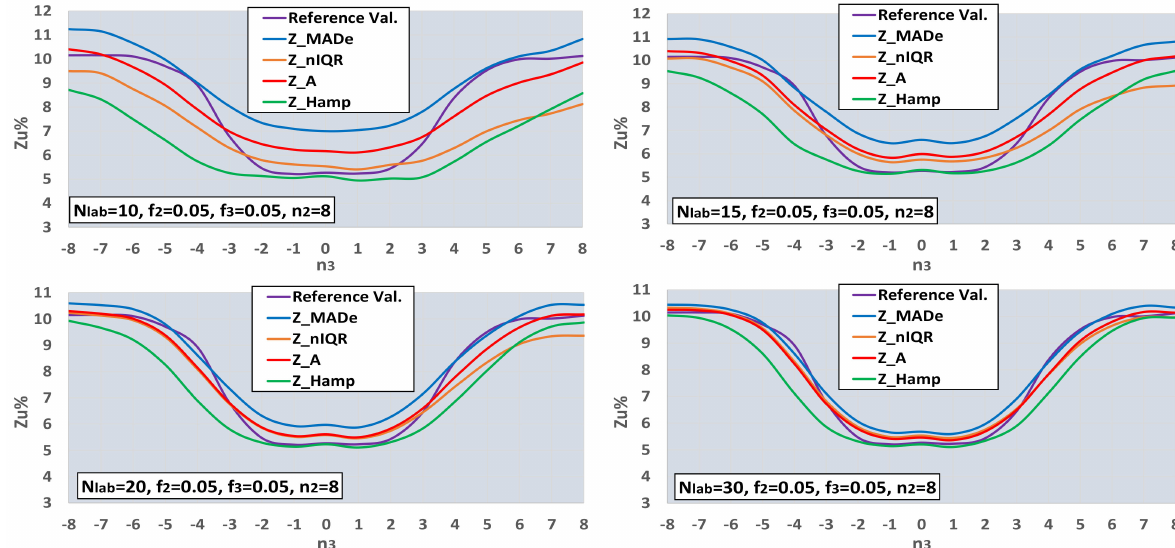
Figure 10. Functions between Zu% and number of standard deviations n 3 , for the reference values and robust estimators, and N lab = 10, 15, 20,